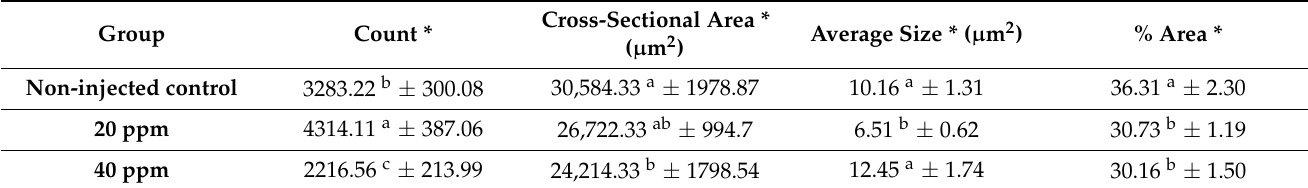
Table 4. Least square means and their standard errors for the effect of treatment (Nano-Ag with 20 ppm and 40 ppm) on the count, cross-sectional area ( µ m 2 ), average size ( µ m 2 ), and % area of muscle fibers from breast muscle samples of day 18 of incubation, ( n = 3 samples from each group, 3 sections from each sample, 9 sections for each group).